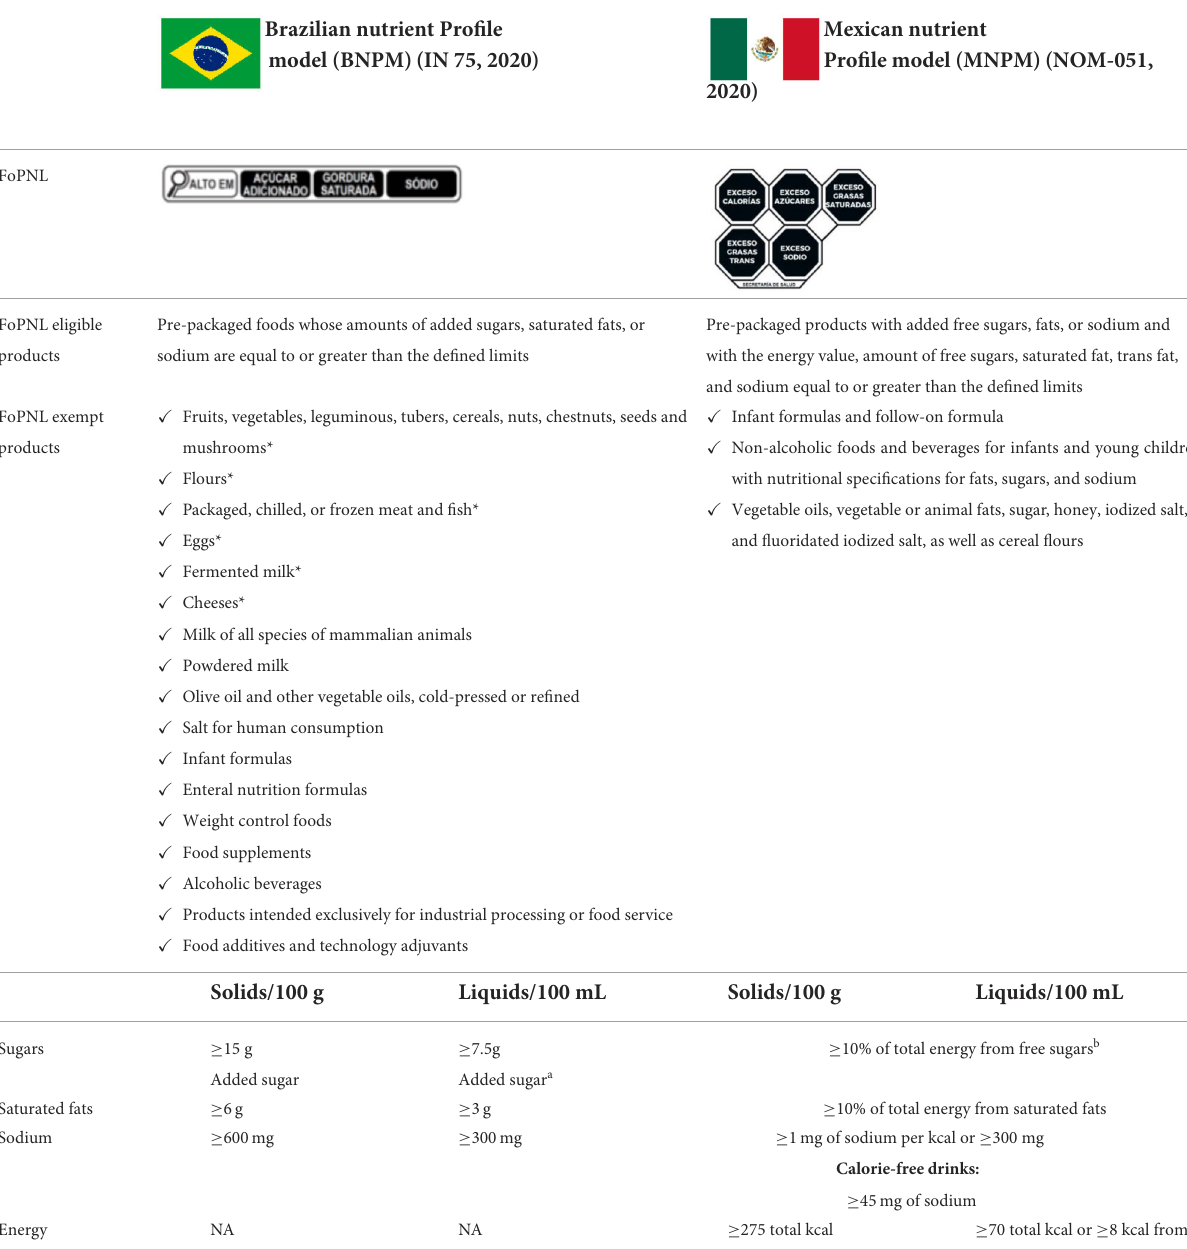
TABLE 1 Eligibility criteria and parameters of Brazilian and Mexican nutrient profile